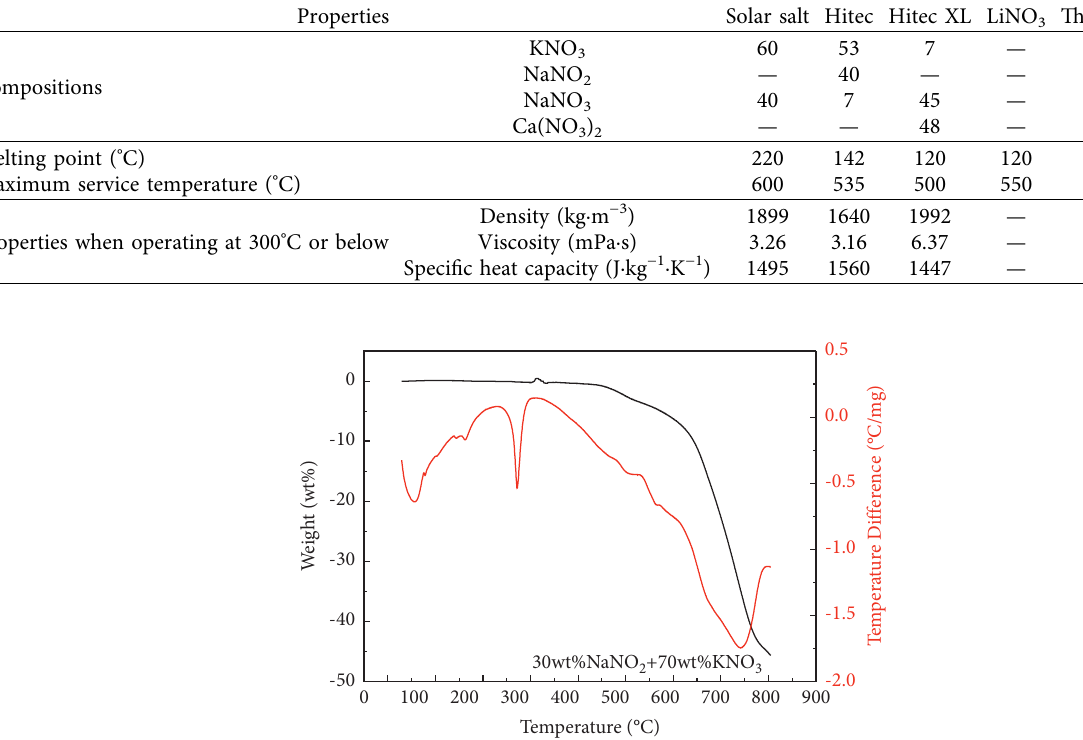
2 -70 wt%KNO 3 mixed